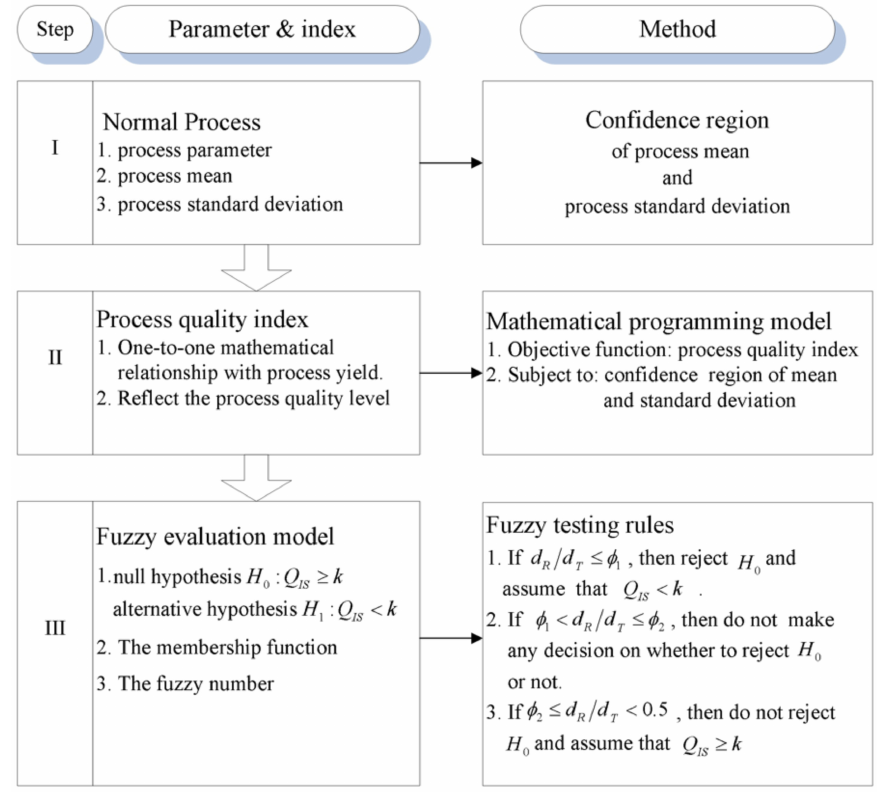
Figure 1. Flowchart of fuzzy evaluation